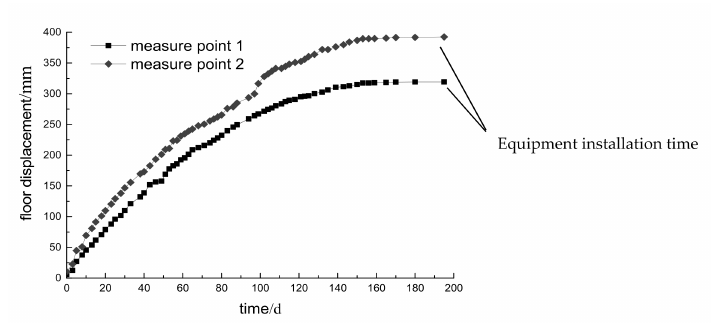
Figure 7. Field monitoring curves.